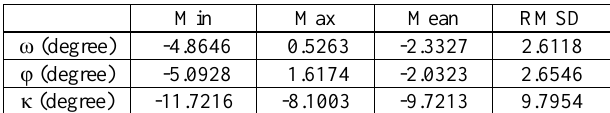
Table 4. The statistic values of difference of rotation